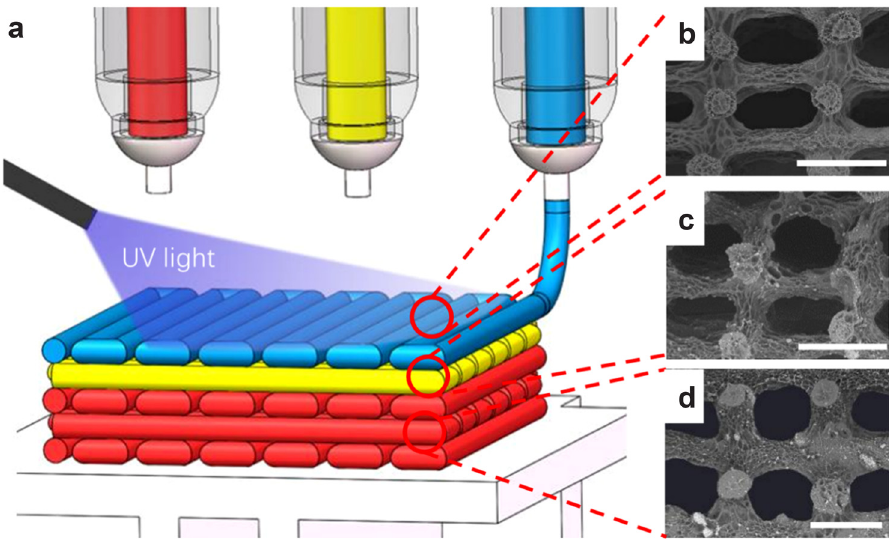
Figure 9: ( a ) Schematic of 3D multi - nozzle pneumatic printing system. 30/3% GelMA/nano - HA ( red ) for subchondral bone layer, 20/3% GelMA/nano - HA ( yellow ) for interfacial layer, 15% GelMA/nano - HA ( blue ) for cartilage layer; ( b ) cartilage layer; ( c ) interfacial layer; ( d ) subchondral bone layer [ 102 ]